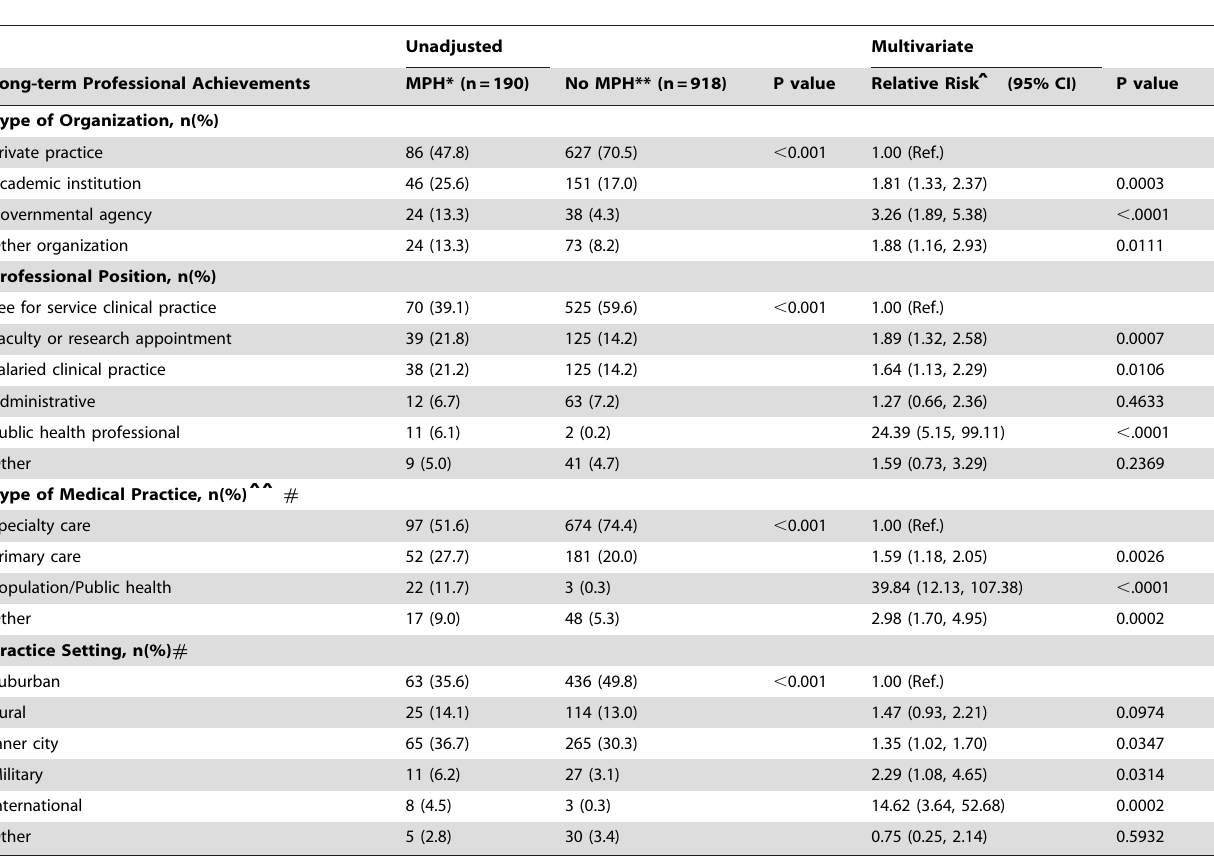
Table 3. Analyses of Long-term Employment and Medical Practice associated with MPH Education Completion among Medical School